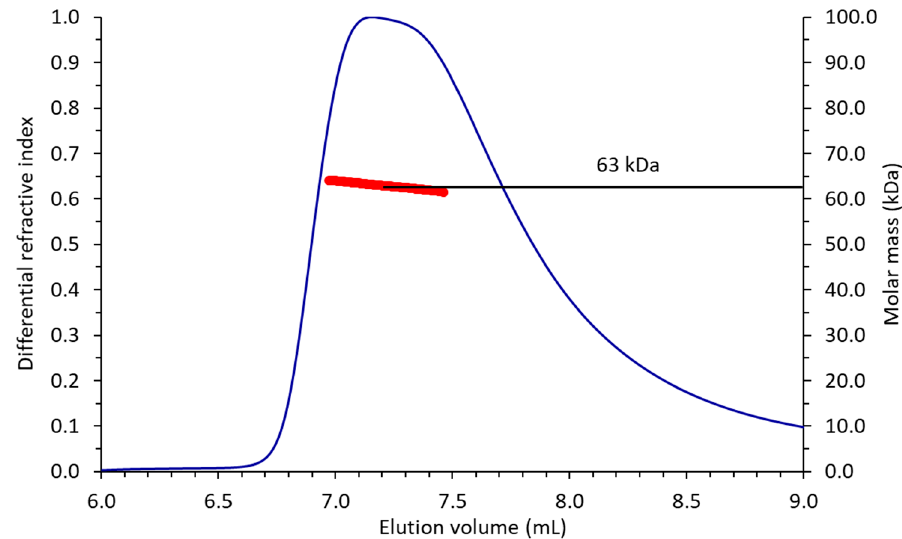
Figure 2. Size-exclusion chromatography–multiangle light scattering profile of EppA. The blue trace is the differential refractive index and the red markers are the calculated molar mass (kDa) at that given elution volume. EppA was monomeric, with an average mass of 63 kDa.